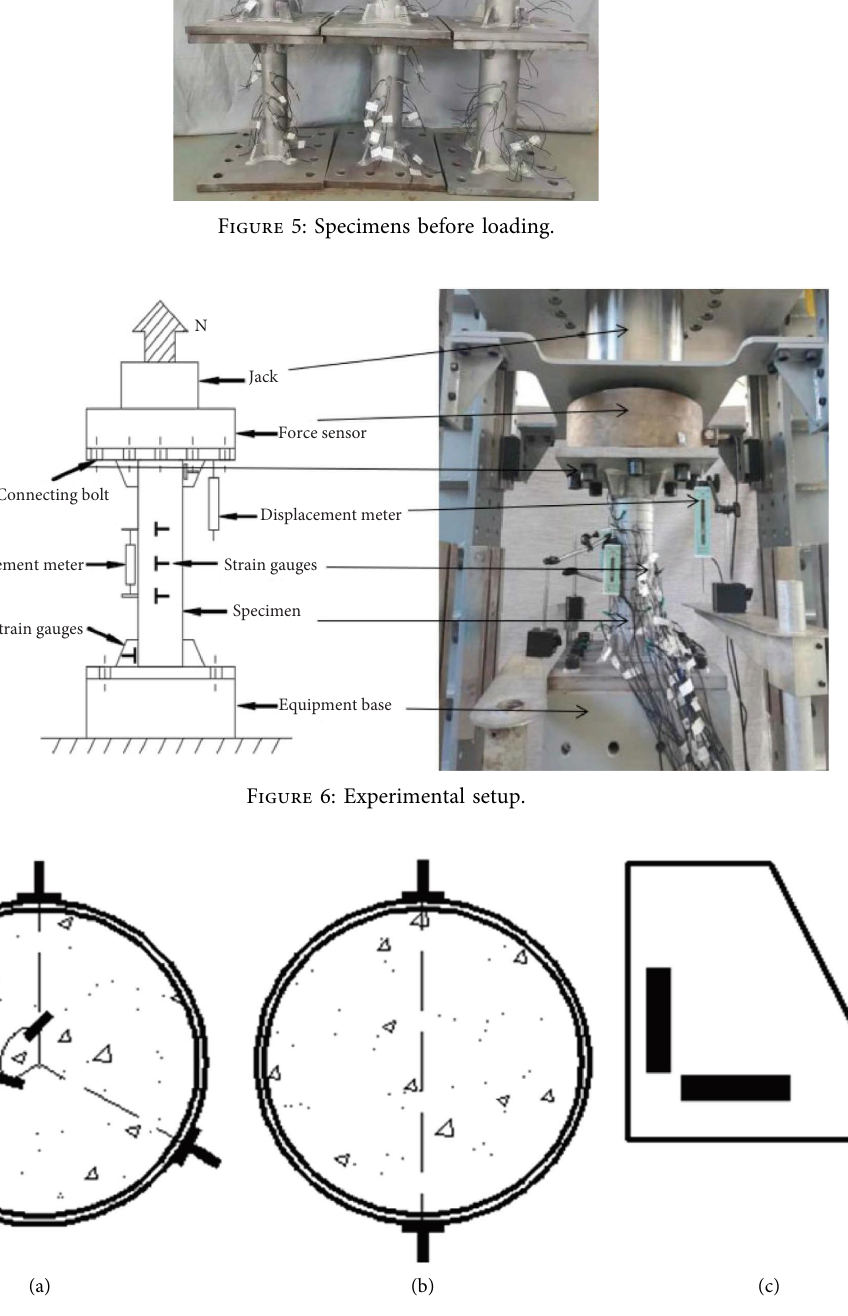
Figure 7: Distribution of strain gauge: (a) 1/2L section, (b) 1/3L section, and (c) stifener.